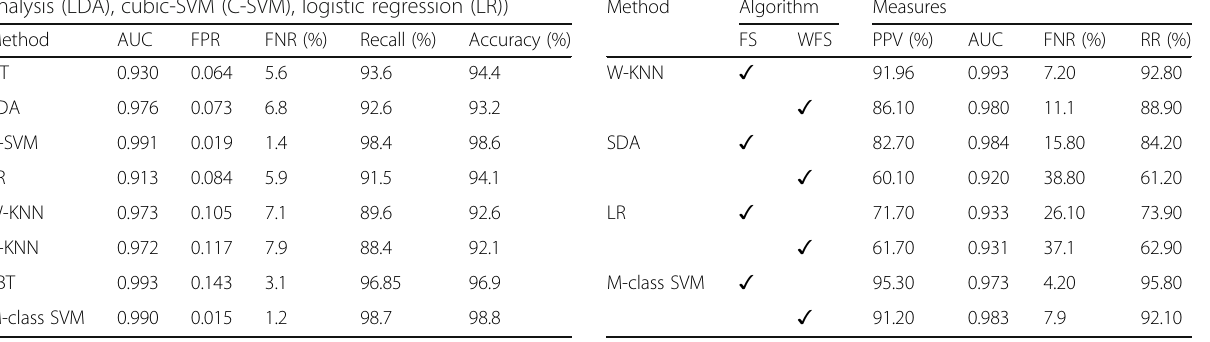
Table 7 Results on INRIA person dataset using eight classification methods (decision tree (DT), linear discriminant